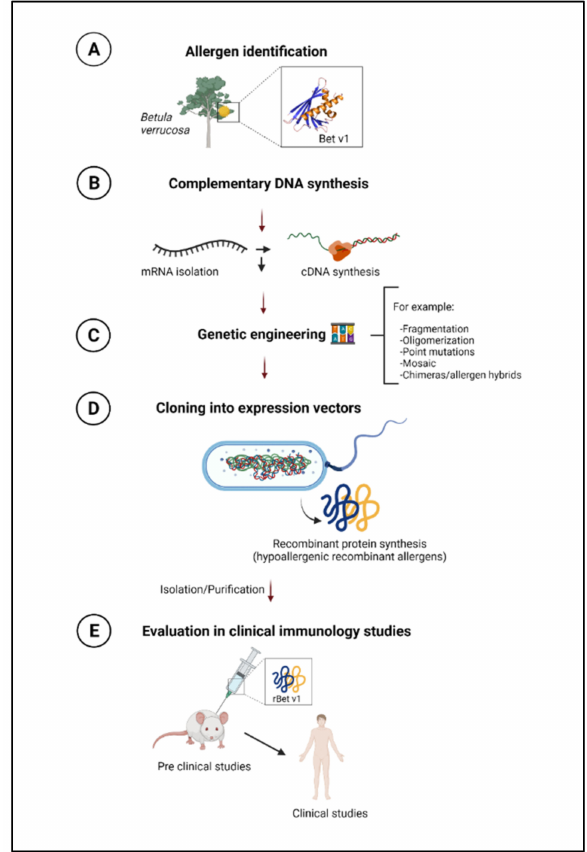
Figure 3. Method for synthesizing recombinant allergens. ( A ) Identification of the amino acid sequence of the proteins associated with allergic symptoms (allergen); ( B ) Isolation of the mes- senger RNA through the use of the genetic code and creation of the successive complementary DNA (cDNA) with the reverse transcriptase enzyme constituting the specific gene for this protein; ( C ) Insertion of the cDNA sequence into the bacterial genetic material ( Escherichia coli ) and polymeriza- tion of the recombinant cDNA, ( D ) Insertion of the recombinant cDNA into the host microorganism with the subsequent synthesis of hypoallergenic recombinant allergens, ( E ) Evaluation in clinical- immunology